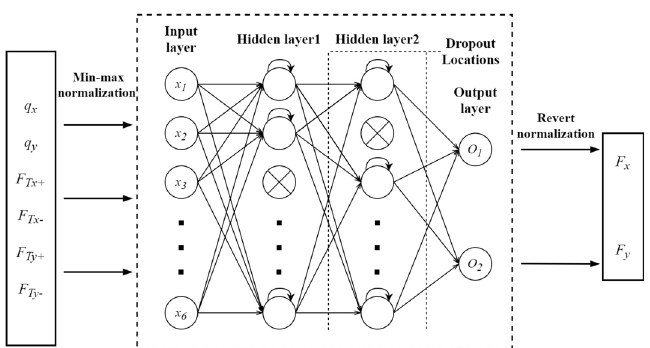
Figure 5. Overview of the RNN-based contact force